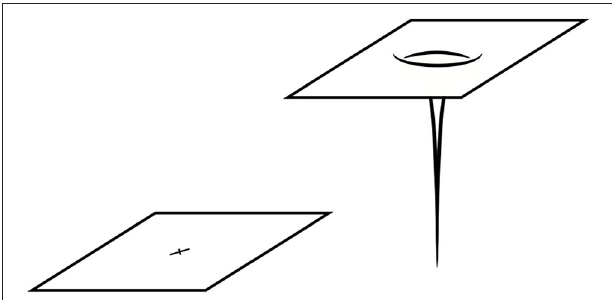
FIGURE 5 | Extremal (Left) and cored (Right) gravitational